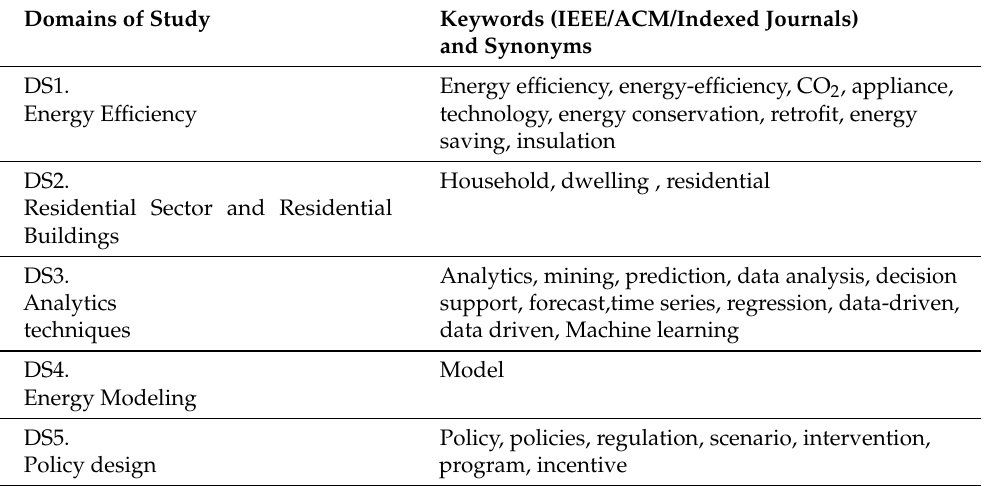
Table 3. Keywords by Domain of Study. Domains of Study Keywords (IEEE/ACM/Indexed